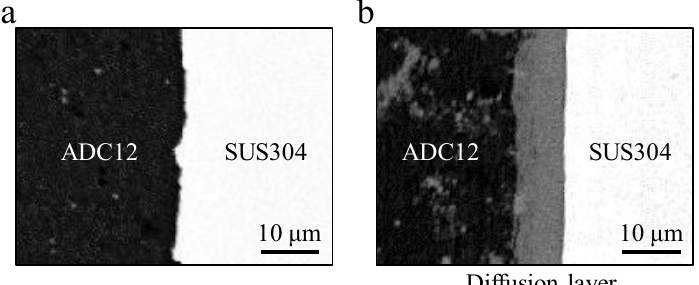
Figure 6. BEIs (backscattering electron images) of bonding interface of ( a ) precursor-coated steel tube and ( b ) Al foam-filled steel tube.